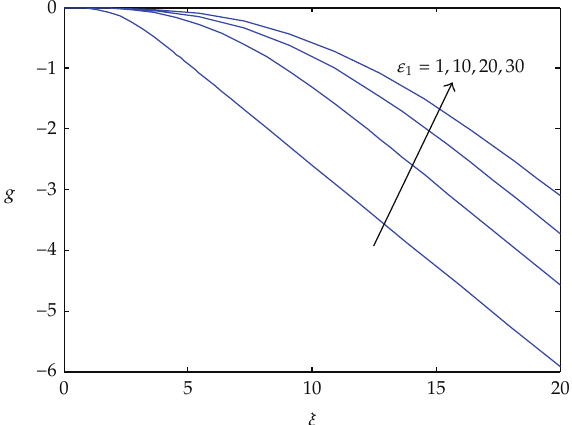
Figure 2: E ff ect of ε 1 parameter on the similarity function g related to the y component of velocity (cid:7) ε 2 (cid:5) 1, n (cid:5) 2 (cid:8)